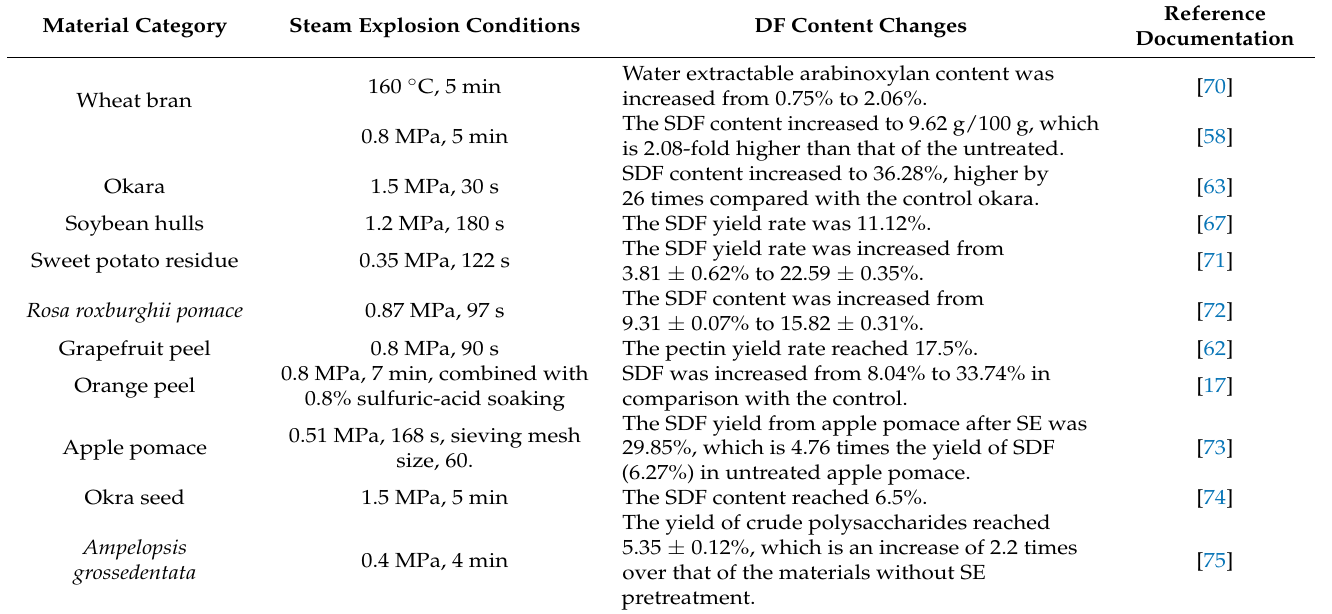
Figure 3. Schematic diagram of the modification mechanism of dietary fiber in Steam explosion. Table 1. Effect of Steam explosion on the dietary fiber content of different food raw